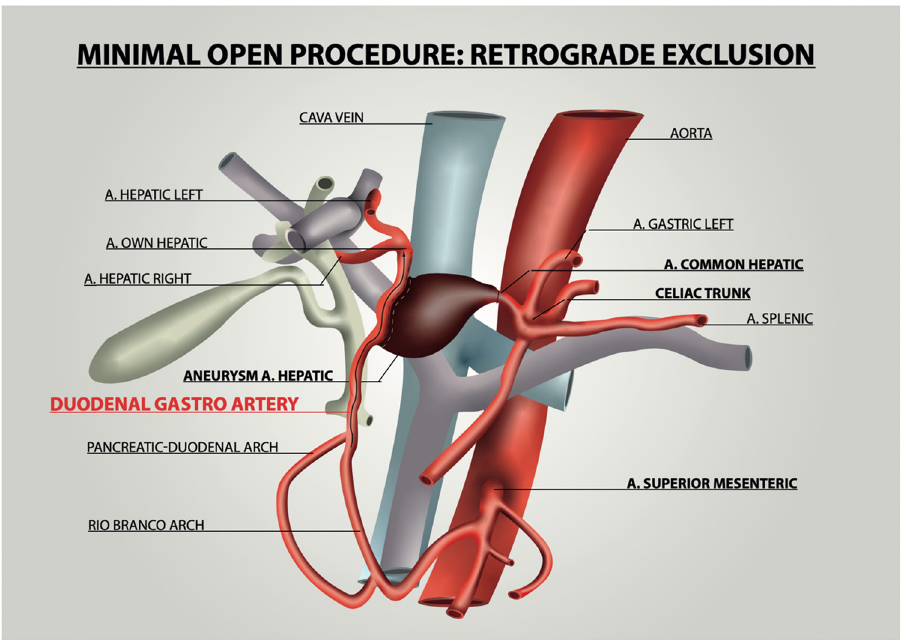
Figure 2: Anatomical representation of CHA aneurism treatment by exclusion by the section of bottom of aneurysm and retrograde thrombosis, ensuring liver blood supply from GDA.